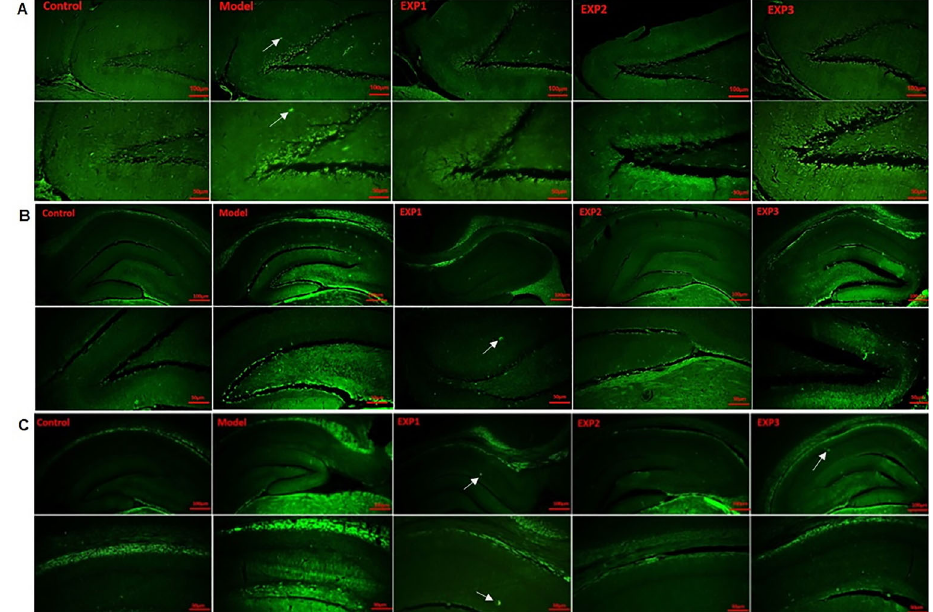
Figure 10. Fluorescence microscopy results of hippocampus samples, showing amyloid fi bril deposits highlighted by thio fl avin S staining ( (cid:1) 40 and (cid:1) 100, scale bars 100 and 50 m m). Green dots indicate amyloid insulin plaques. White arrows indicate amyloid plaques in the model group. A , Insulin amyloid plaques in the presence and absence of trans- chalcone in the dentate gyrus region, ( B ) in the presence and absence of silibinin in the dentate gyrus region, and ( C ) in the presence and absence of silibinin in the CA1 region. See Table 1 for group